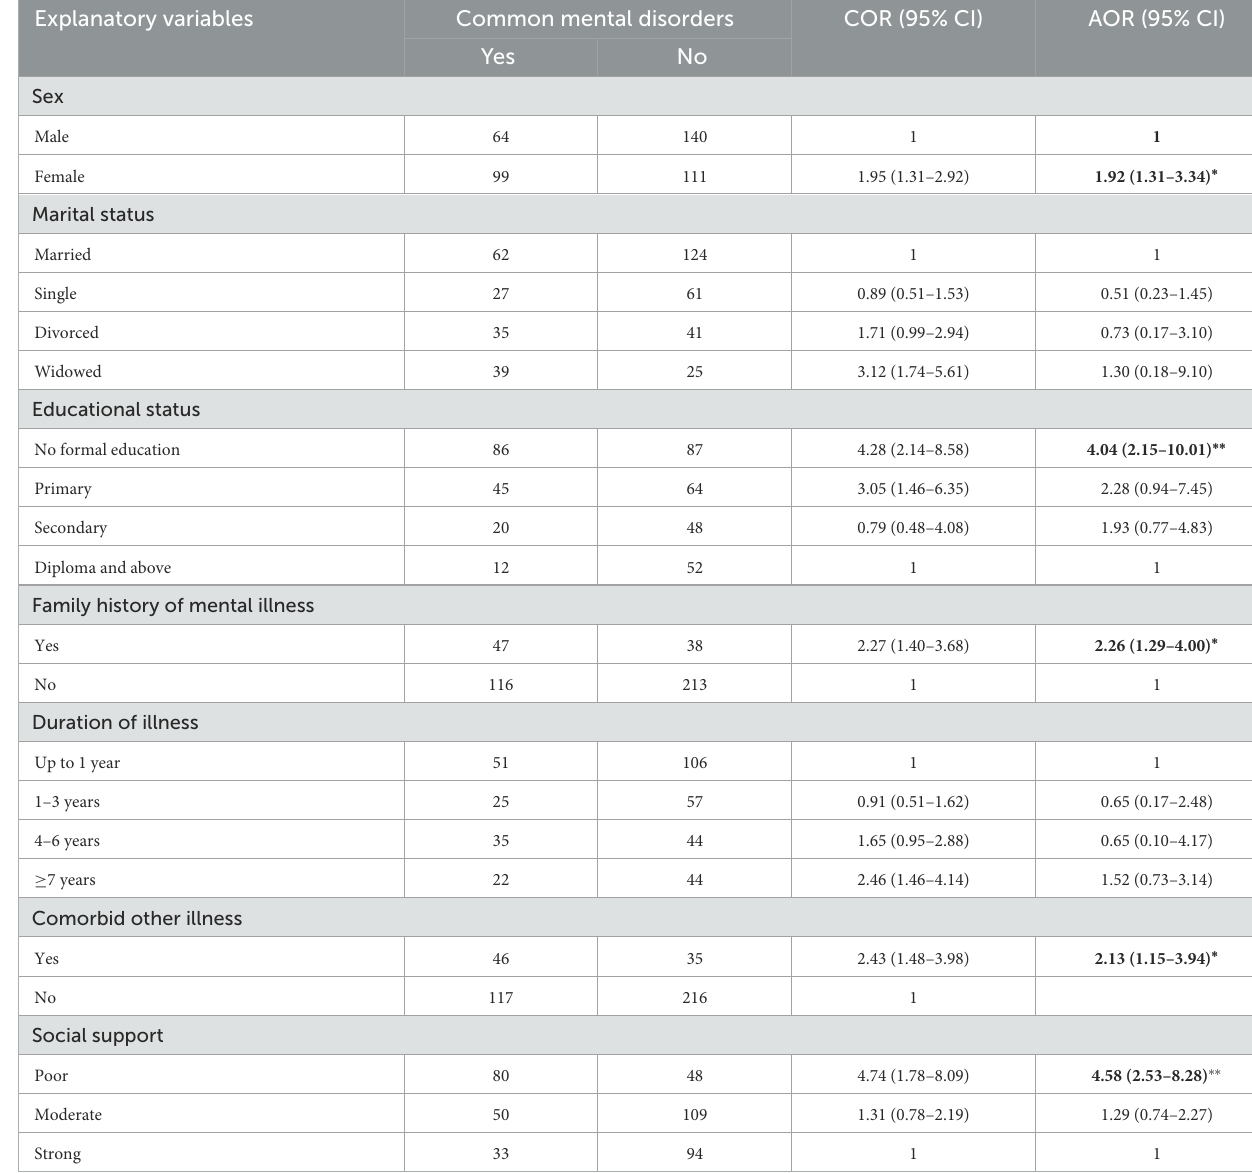
TABLE 4 Factors associated with common mental disorders in multivariate and bivariate logistic regression analysis among primary caregivers of adult patients with mental illness attending at Harari region state public hospitals, Eastern Ethiopia, 2022 ( n = 414). Explanatory